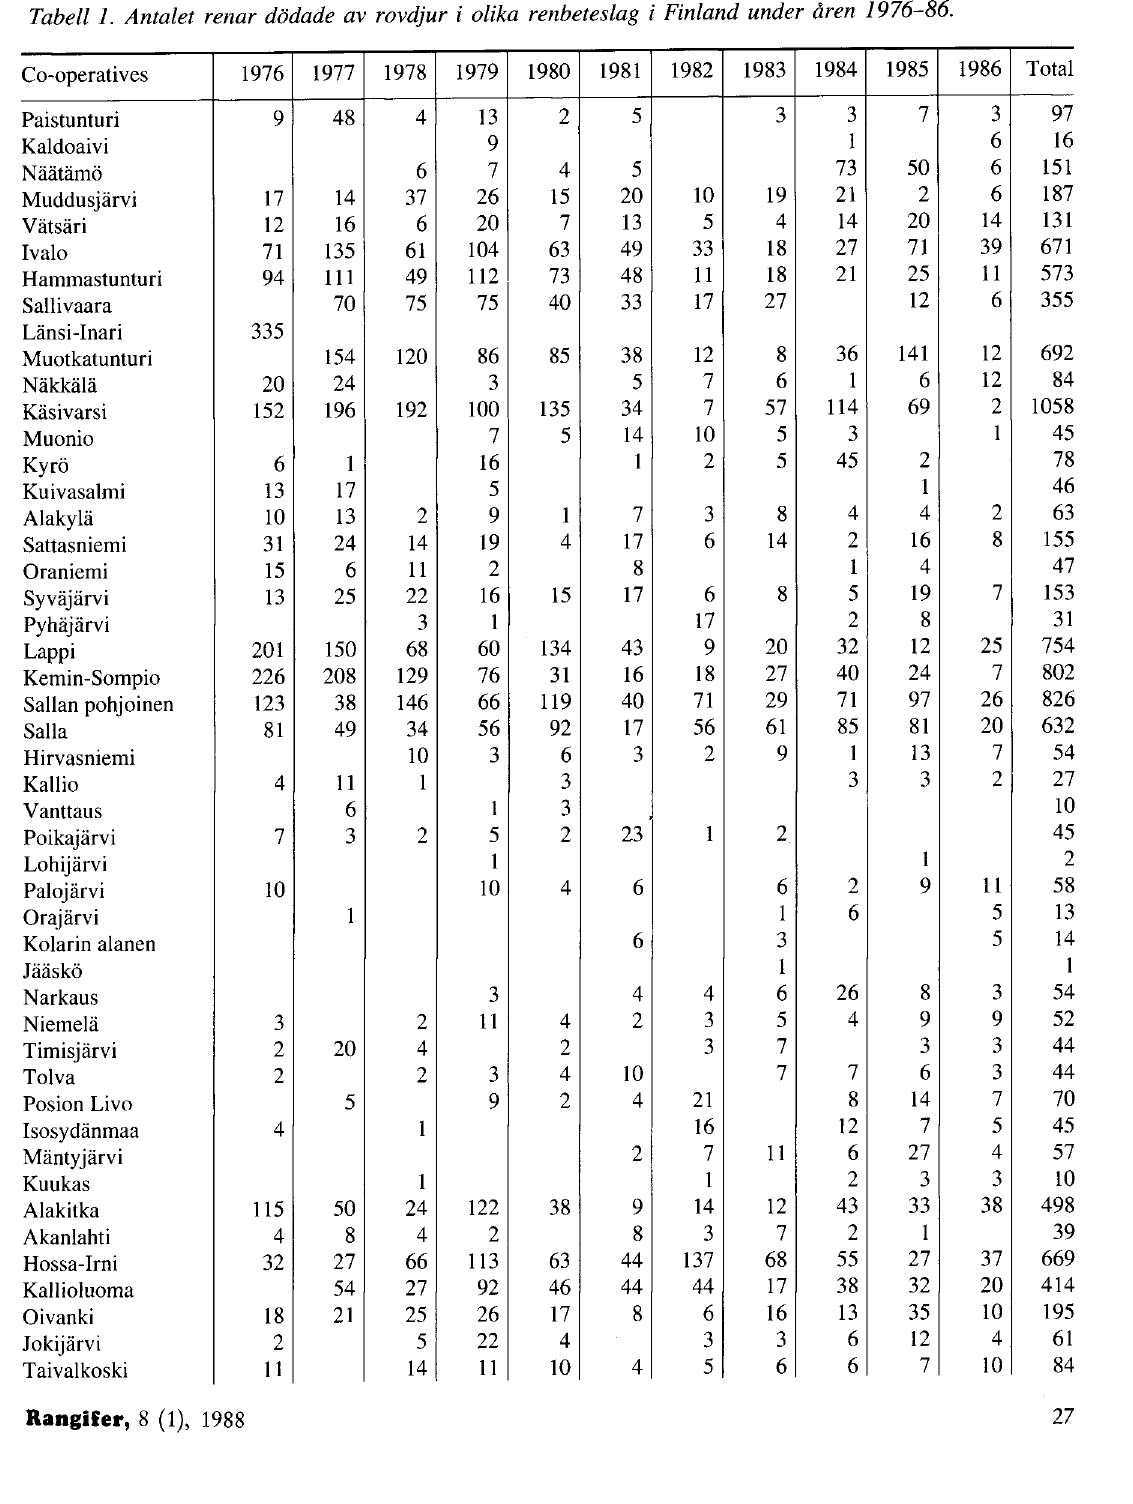
Table 1. Numbers of reindeer killed by predators during 1976-86 in different reindeer herding co-opera tives in